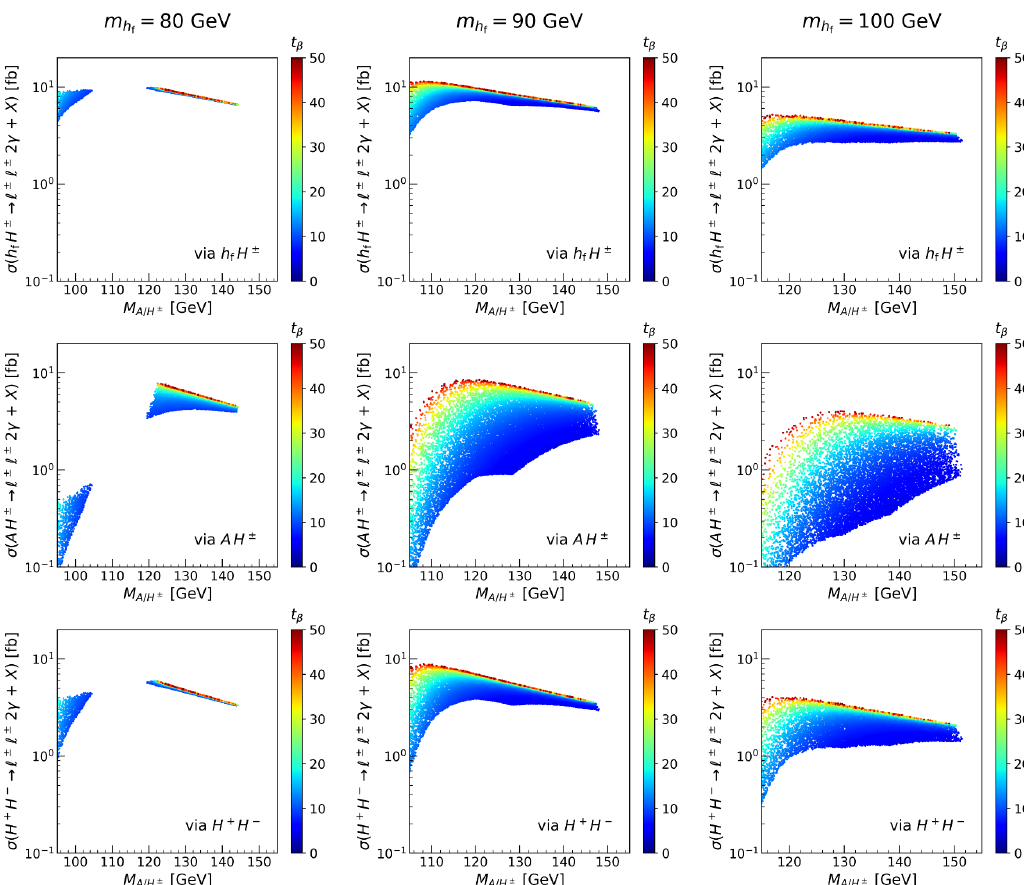
Figure 9 . σ ( pp → ‘ ± ‘ ± γγX ) at the 14 TeV LHC about M , through pp → H ± h f (upper A/H ± panels), pp → AH ± (middle panels), and pp → H + H − (lower panels). The color code denotes t β . The results of m h = 80 , 90 , 100 GeV are in the left, middle, and right panels, respectively. The f parameter points satisfy Step A, Step B, the CDF 4 γX constraint, and Λ cut > 10 18 GeV .